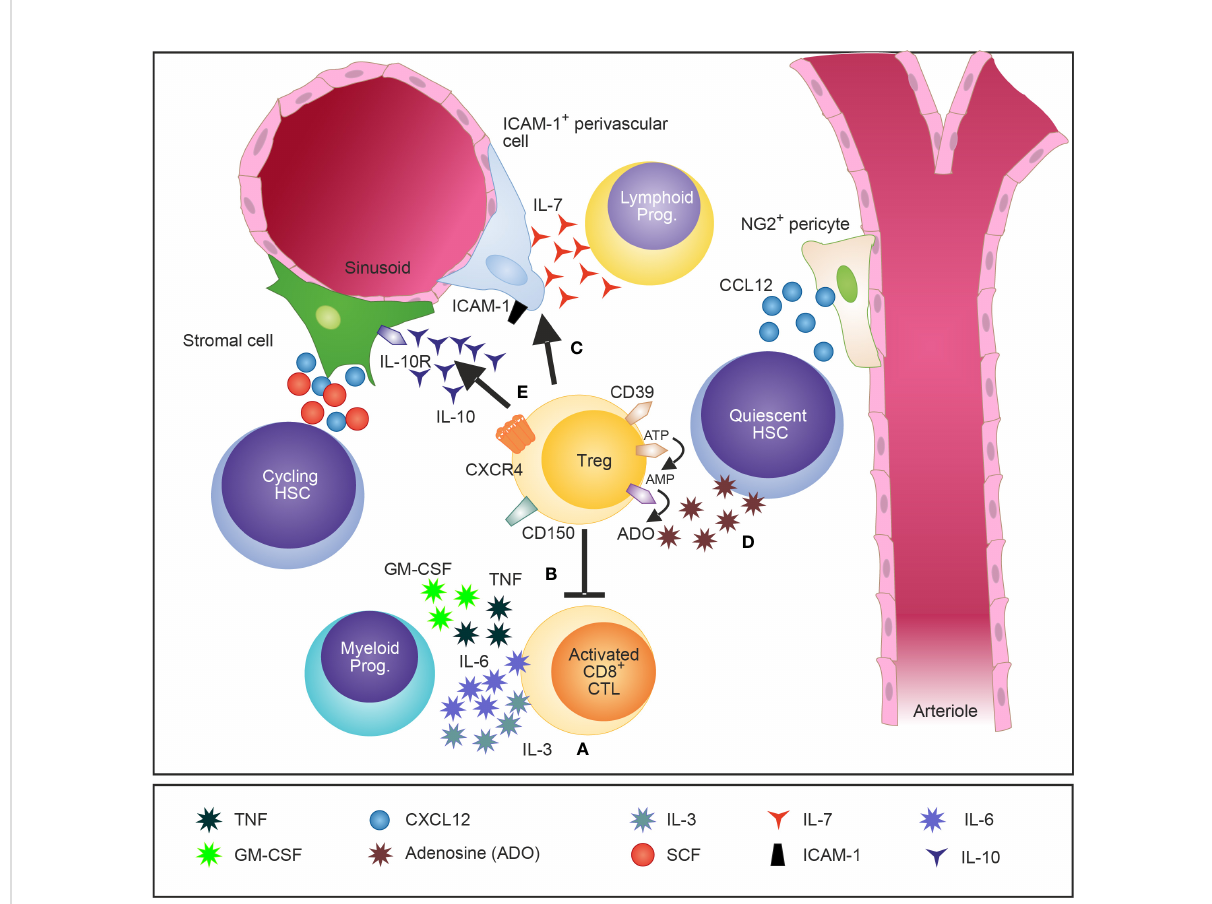
FIGURE 1 A schematic illustration of Tregs in the BM and their attributed effects on the HSCs niche and HSPCs. Tregs in the BM are widely distributed and localize close to the endosteum adjacent to HSCs. Tregs regulate IL-3 mediated differentiation of myeloid progenitors (A) (28) and modulate basal hematopoietic output by restricting production of myelopoiesis-promoting cytokine production by activated CD8 T cells in the BM (B) (45). Furthermore, Tregs control indirectly lymphopoiesis by mediating the release of the lymphoid cell growth and survival factor IL-7 by ICAM- 1 + stromal cells of the HSC niche (C) (27). CD150 + Tregs were recently identi fi ed as crucial regulators of HSC quiescence and engraftment of HSCs into the BM after allogeneic BM transplantation (D) (26). In addition, IL-10 secreting Tregs have been shown to modulate the function of IL-10R-expressing BM stromal cells (E)